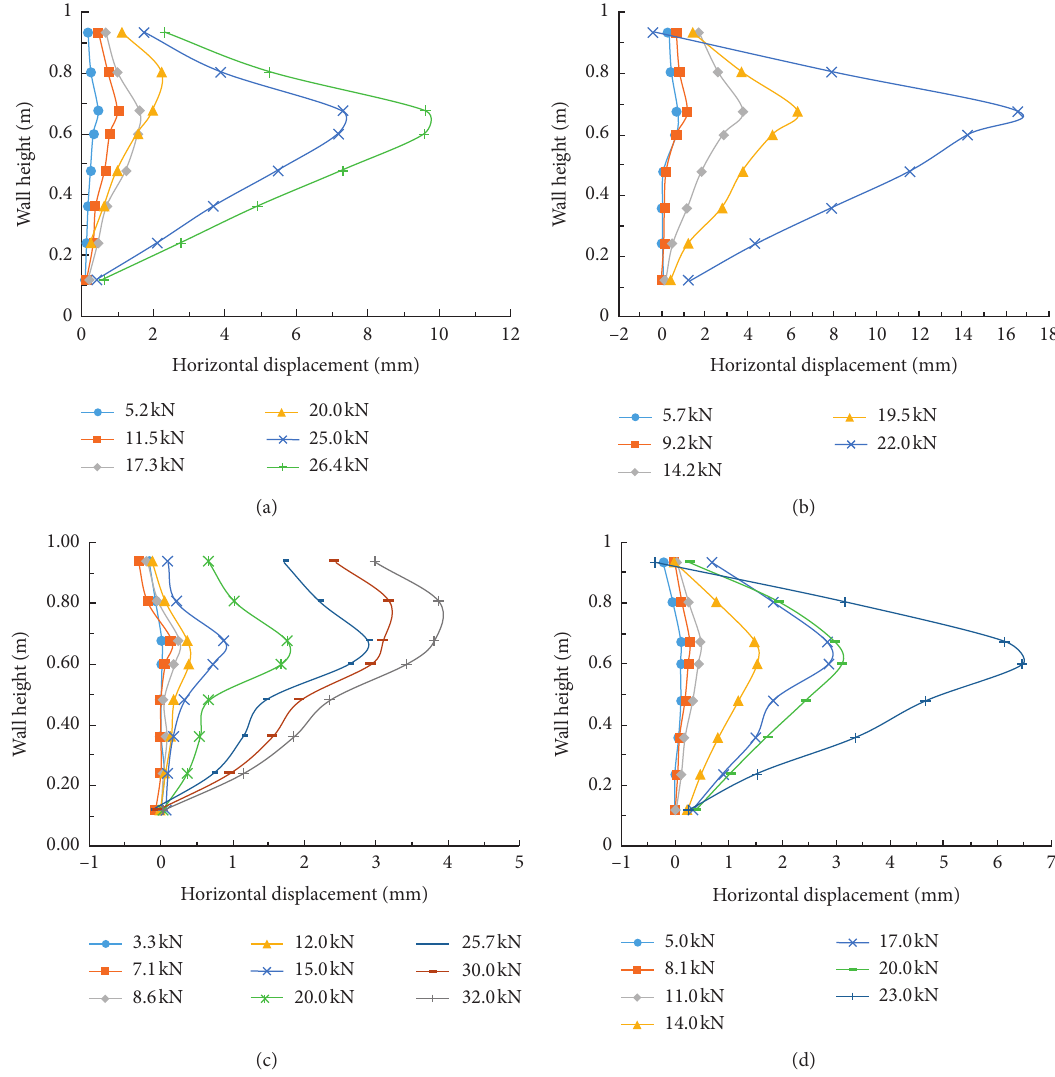
Figure 6: The displacement distribution rule of side walls of various models. (a) Flat seam type. (b) Round hinged type. (c) Integral type. (d) Mortise